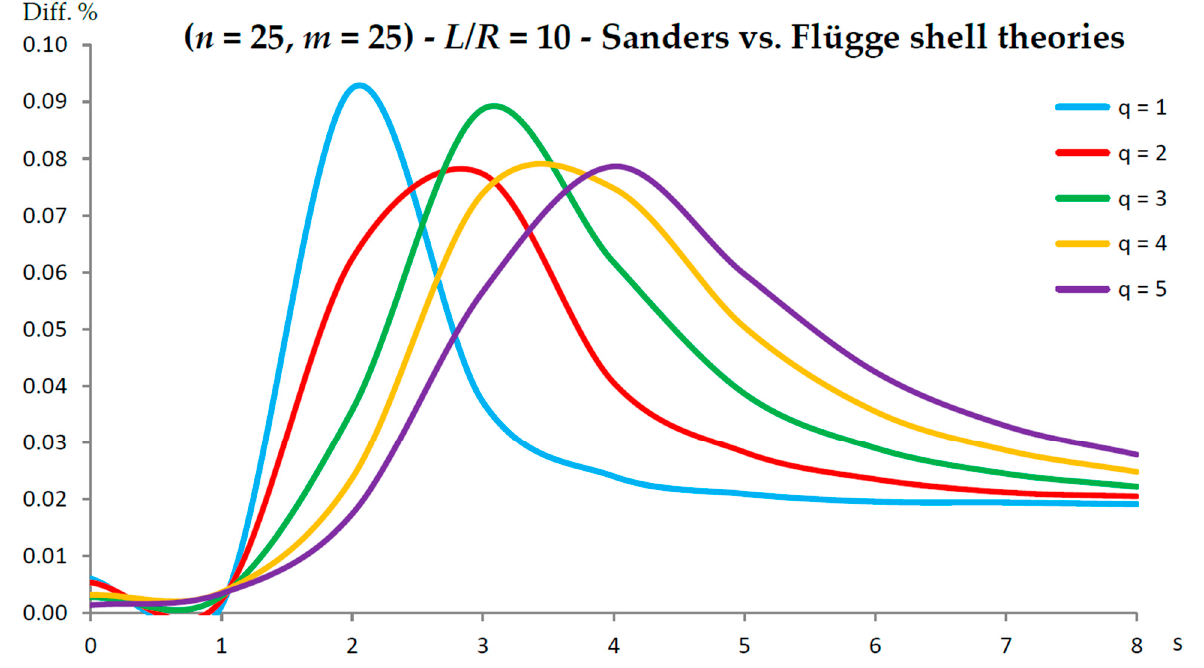
Figure 7. Percentage differences between the radial natural frequencies obtained via Sanders and Flügge shell theories (Flügge as the reference). Anisotropic elastic shell model. Simply supported SWCNT of Table 1 with chirality indices ( n = 25, m = 25 ) and aspect ratio L / R = 10. Number of longitudinal half-waves q . Number of circumferential waves s .